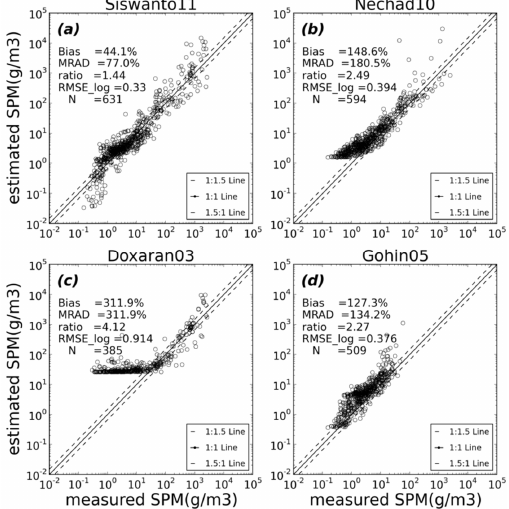
Figure 6. Comparison of the measured and inversed SPM values when the models of ( a ) Siswanto11 , ( b ) Nechad10 ; ( c ) Doxaran03 ; and ( d ) Gohin05 are applied to the whole R rs in situ data set. Solid and dashed lines represent the 1:1 and 1.5:1, 1:1.5 lines, respectively. The corresponding statistic indicators values are given in each panel. The number of data points are not always the same due to the limitation of the model (panel ( b , d )) or the unavailability of the input reflectance (panel ( c